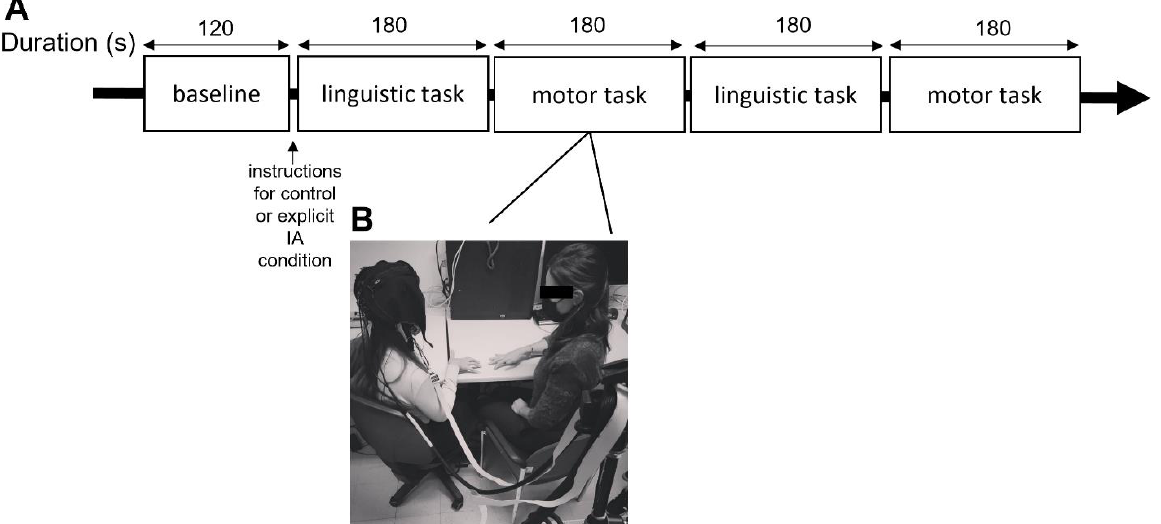
Figure 1. Experiment setup. ( A ) The experimental procedure with the synchronization tasks dura- tion and timing of the instructions provided for the explicit IA and control conditions. ( B ) Example of the experimental setting with fNIRS device recording and the experimenter during the task exe- cution (i.e., for the motor task).